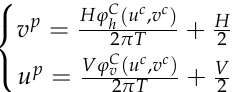
Figure 6. Phase mapping relationship of chromatic aberration compensation for the red channel.